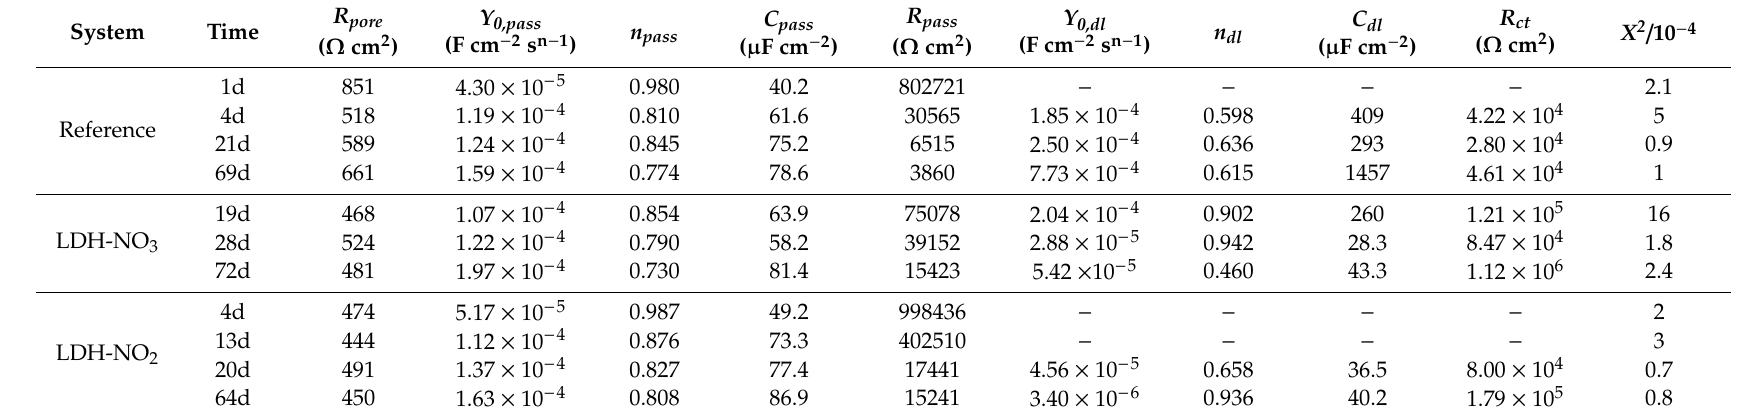
Table 2. Parameters determined by numerical fitting of the EIS spectra shown in Figure 8 with capacitances calculated using Equation